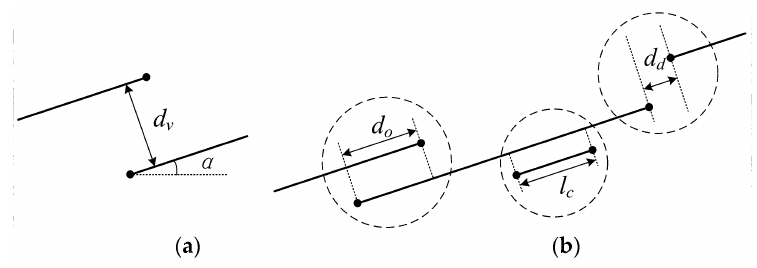
Figure 3. The premise and criteria for merging ( a ) The premise of merging; ( b ) Three criteria of merging (in dashed circles).